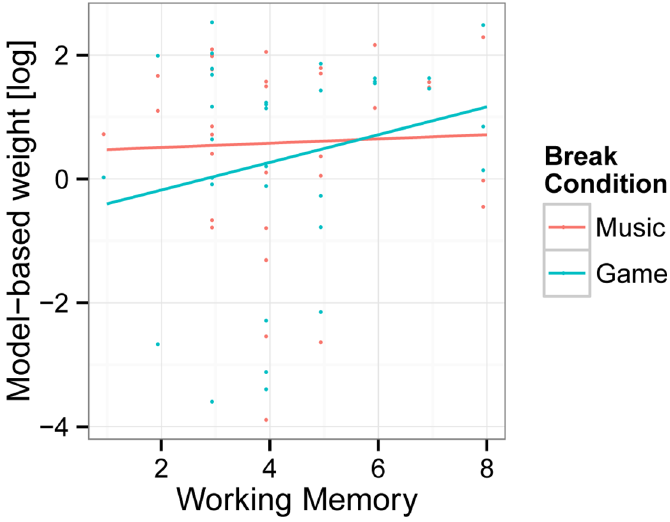
Fig 2. Computational model parameter estimates. The model parameter β GD , estimating the weight of the goal-directed systems to behavioral control, is displayed as a function of working memory capacity (Digit Span score) for the break conditions gaming (green points and regression lines) versus music